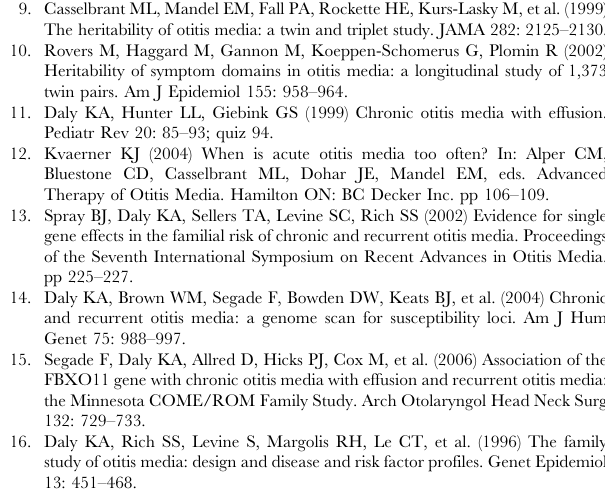
Table S1 Criteria for Classifying Family Members as Affected with COME/ROM for the University of Minnesota